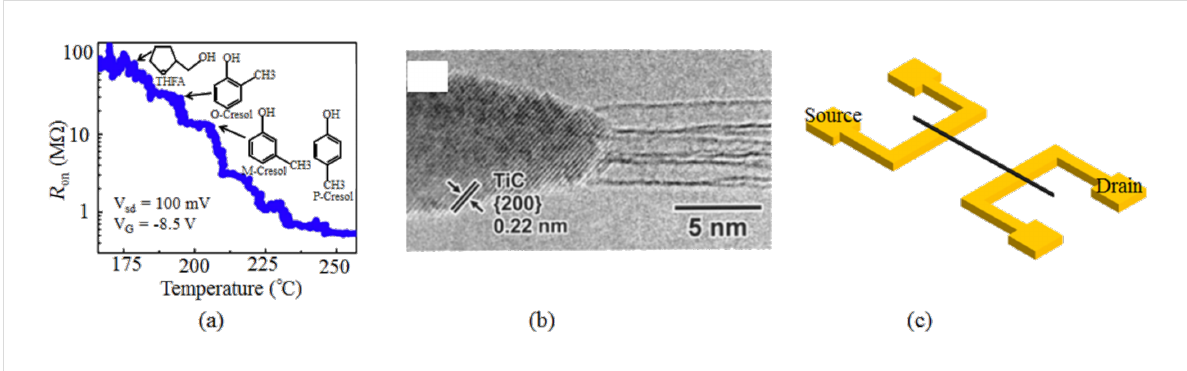
Figure 9: Improving the contact performance by post-metallization annealing. a) The process of removing contamination from the sidewalls of SWCNTs by annealing at modest temperatures. b) The TEM image shows the TiC formation through annealing Ti–SWCNT contacts above 800 ºC. c) The schematic of contact design using the Joule heating method for local annealing of the metal–SWCNT contact (using Pd as the contact metal) by pulsed current. Figure reprinted with permission from (a) [70] copyright 2011 Author(s) and (b) [50] copyright 1999 The American Association for the Advancement of